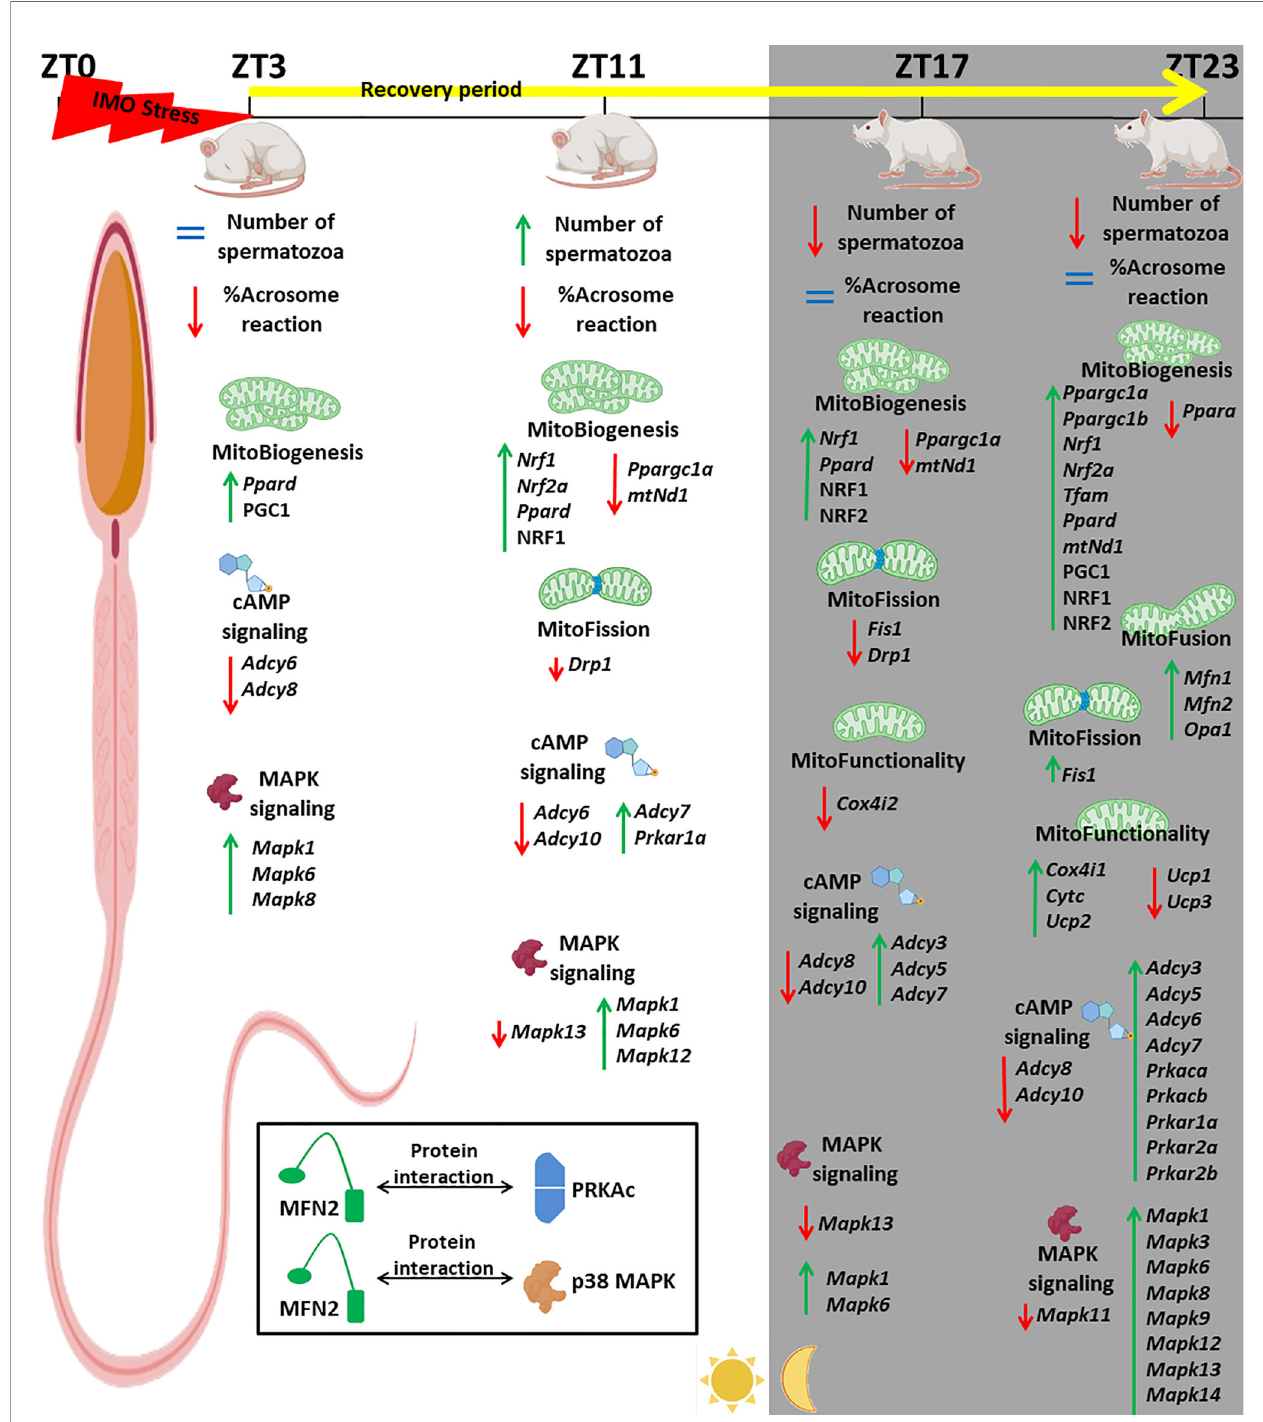
FIGURE 13 | Acute stress, the most common stress in human society, signi fi cantly changes 91% of followed mitochondrial dynamics and functionality markers as well as 91% of signaling molecules regulating spermatozoa homeostasis and mitochondrial dynamics/functionality. The most prominent changes were observed 20 h after the end of the stress. The physiological signi fi cances are the recovery of spermatozoa number and functionality (positive acrosome reaction). Furthermore, the interactions between the proteins important for spermatozoa homeostasis and functionality (MFN2 and PRKA catalytic subunit, MFN2, and p38MAPK) are shown for the fi rst